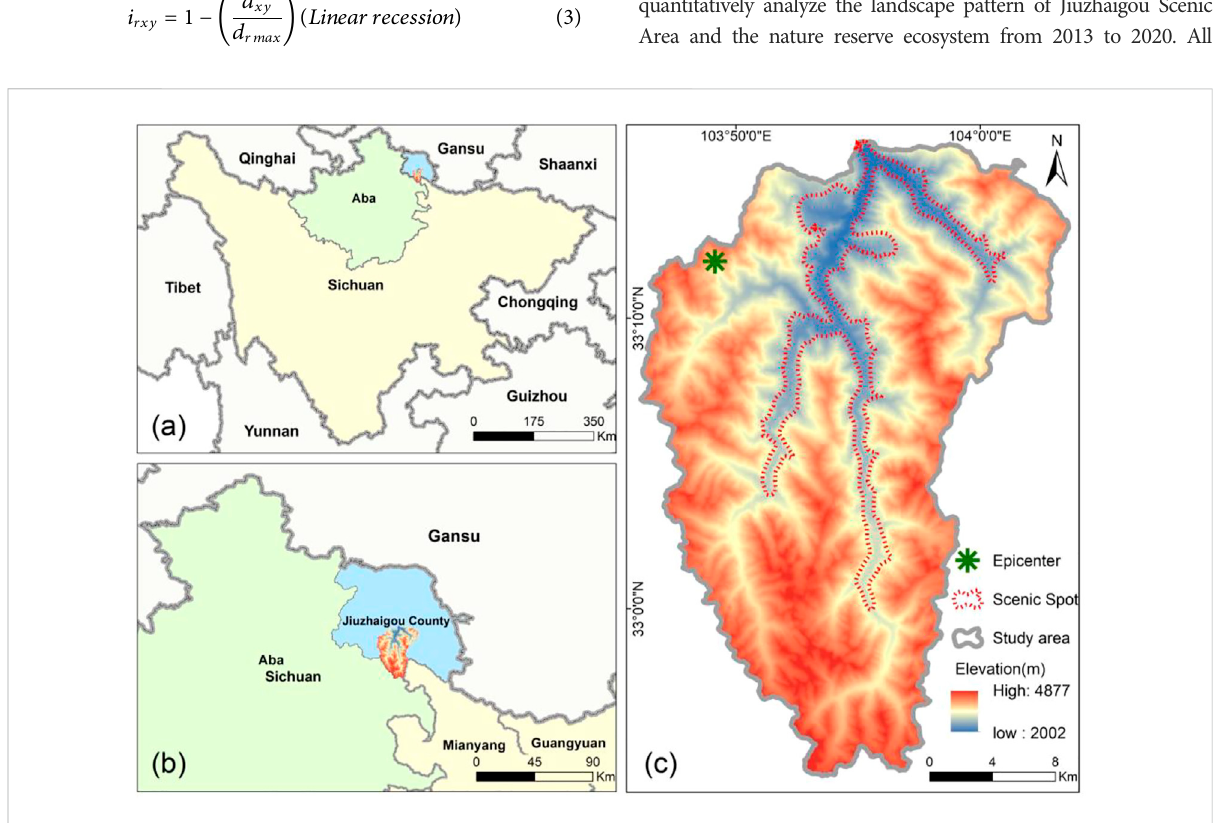
FIGURE 1 Geographical location of the study area. (A) Location of Jiuzhaigou in Sichuan Province. (B) Location of Jiuzhaigou in Jiuzhaigou County. (C) The study area in Jiuzhaigou.